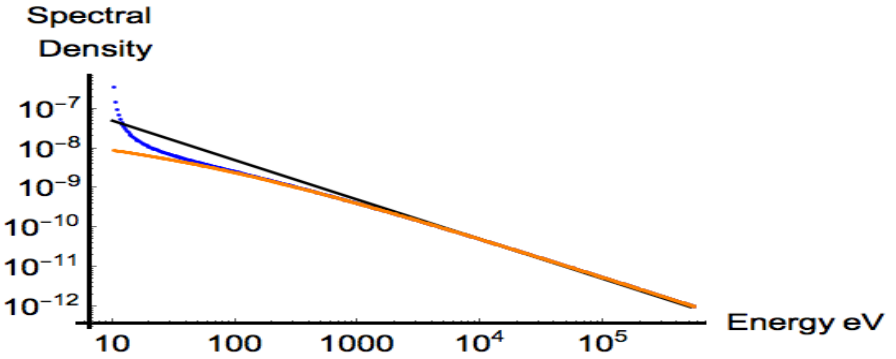
Figure 8. Log-log plot of the spectral density for the 2S shift (orange) and the 2S–2P Lamb shift (blue) versus energy. The solid black line is the 1/ E